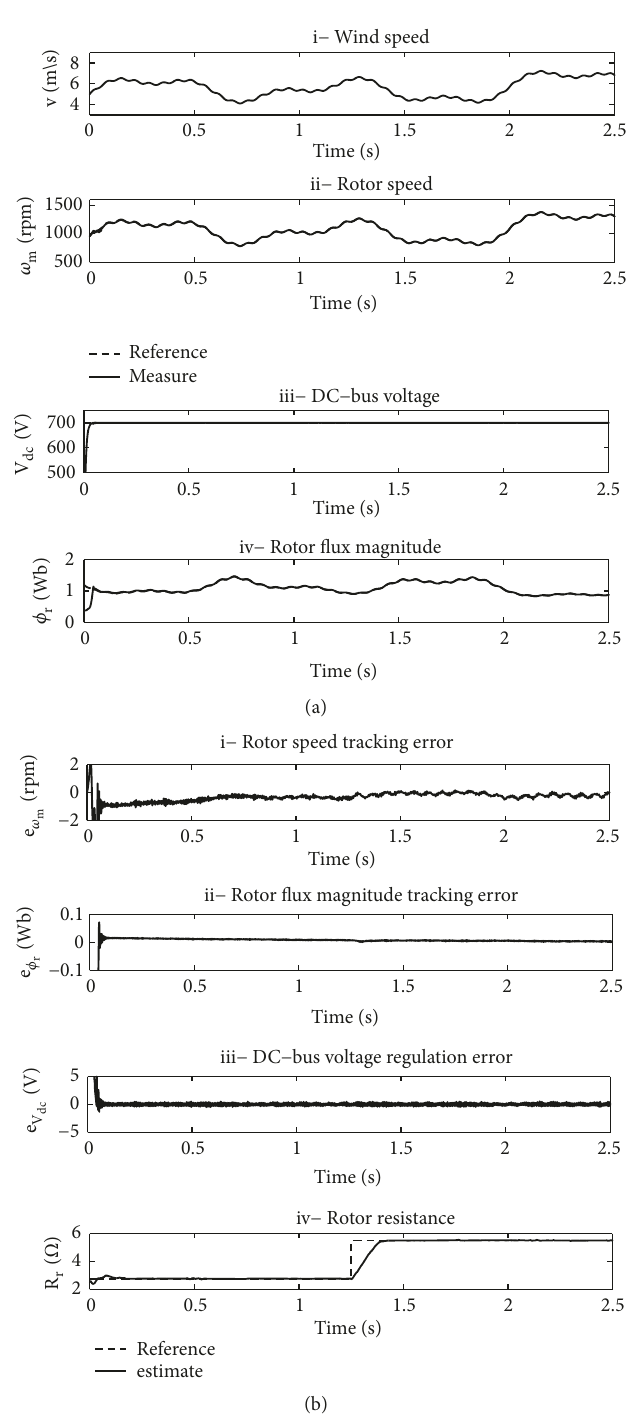
Figure 6: Performances of the generator side RBF neurosliding controllers under variation of the rotor speed and 100% online variation of rotor resistance. (a) Wind speed (i), rotor speed (ii), rotor flux magnitude (iii), and DC bus voltage (iv). (b) Rotor speed tracking error (i), rotor flux magnitude tracking error (ii), DC bus voltage regulation error (iii), and rotor resistance